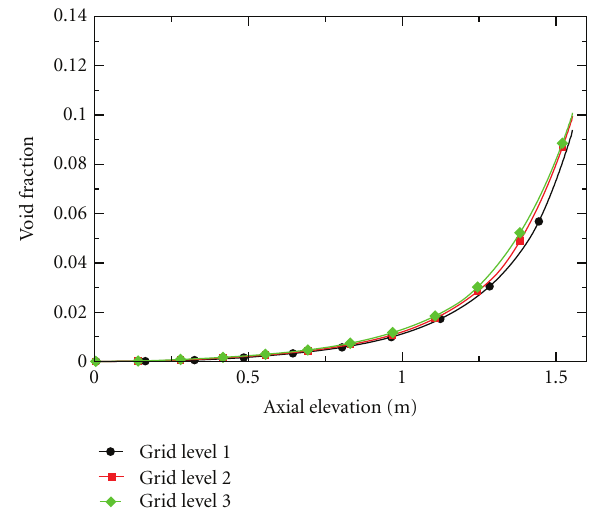
Figure 12: Ruyer-Seiler model: Grid influence on the void-fraction evolution for run